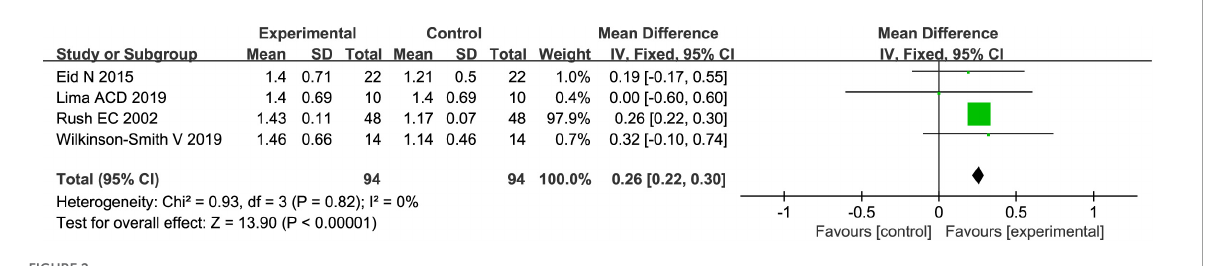
FIGURE2 Effect of fruit intervention on stool frequency in the fixed-effect meta-analysis.